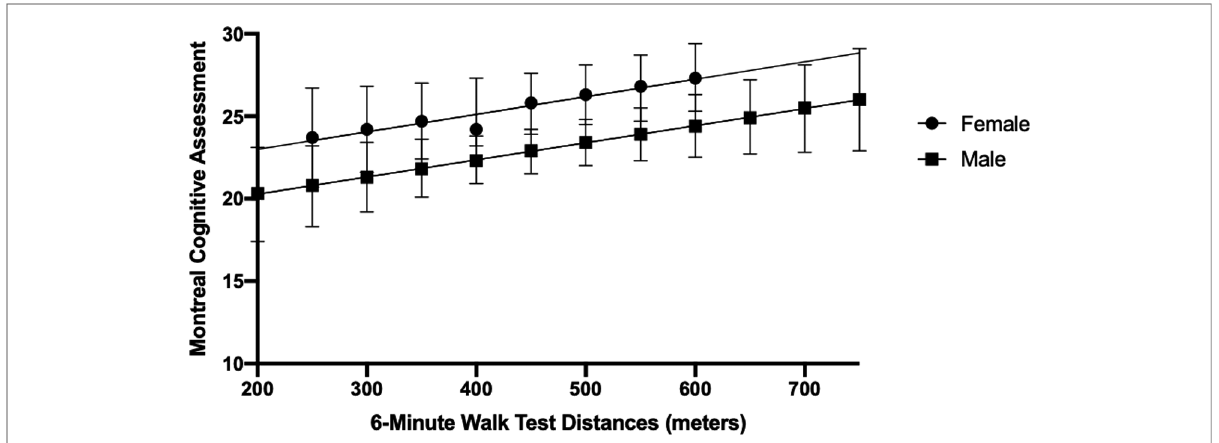
FIGURE 2 Marginsplot of sex differences in the association between global cognitive function (Montreal Cognitive Assessment scores) and Walking Capacity (6- Minute Walk Test distance) when adjusting for age, height and history of stroke. Main effect of sex ( p <0.05). Bars depict the 95% Con fi dence